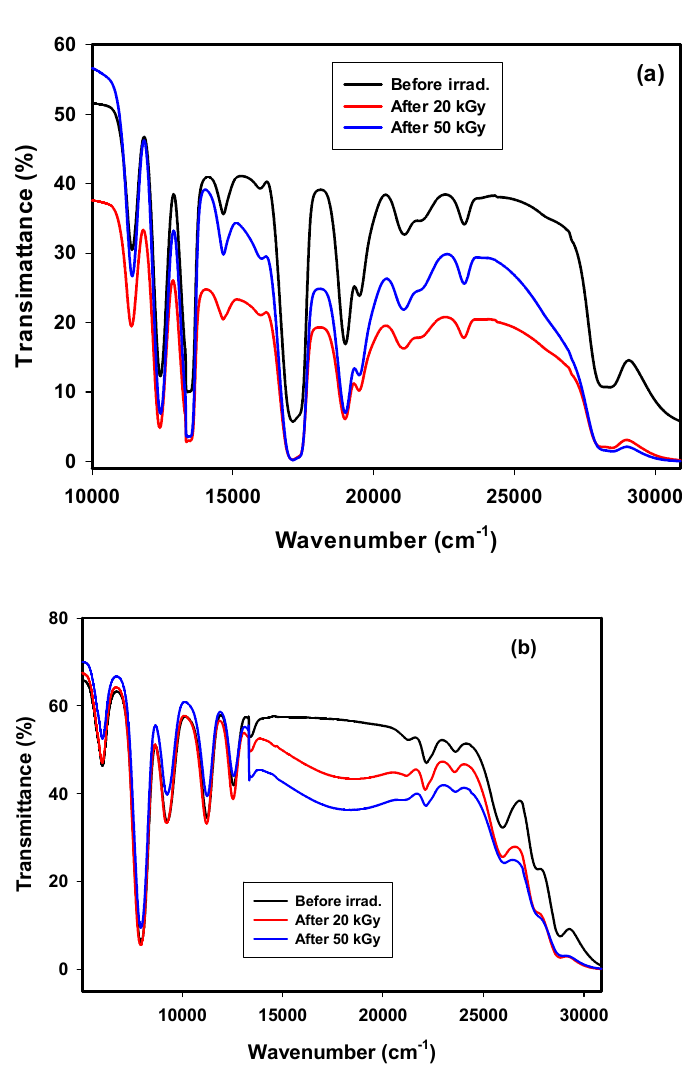
Figure 5. Transmittance spectra of ( a ) GRN and ( b ) GRD samples at room temperature.